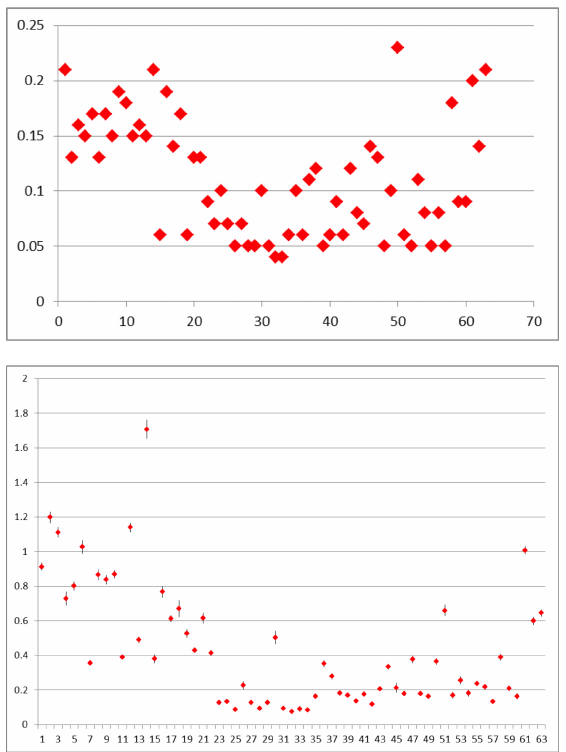
Figure 14: Accuracy for each church (numbered 1–61) in metres: The upper diagram shows median value of absolute differences between model and point cloud, the lower diagram shows arith- metic mean and standard deviation.